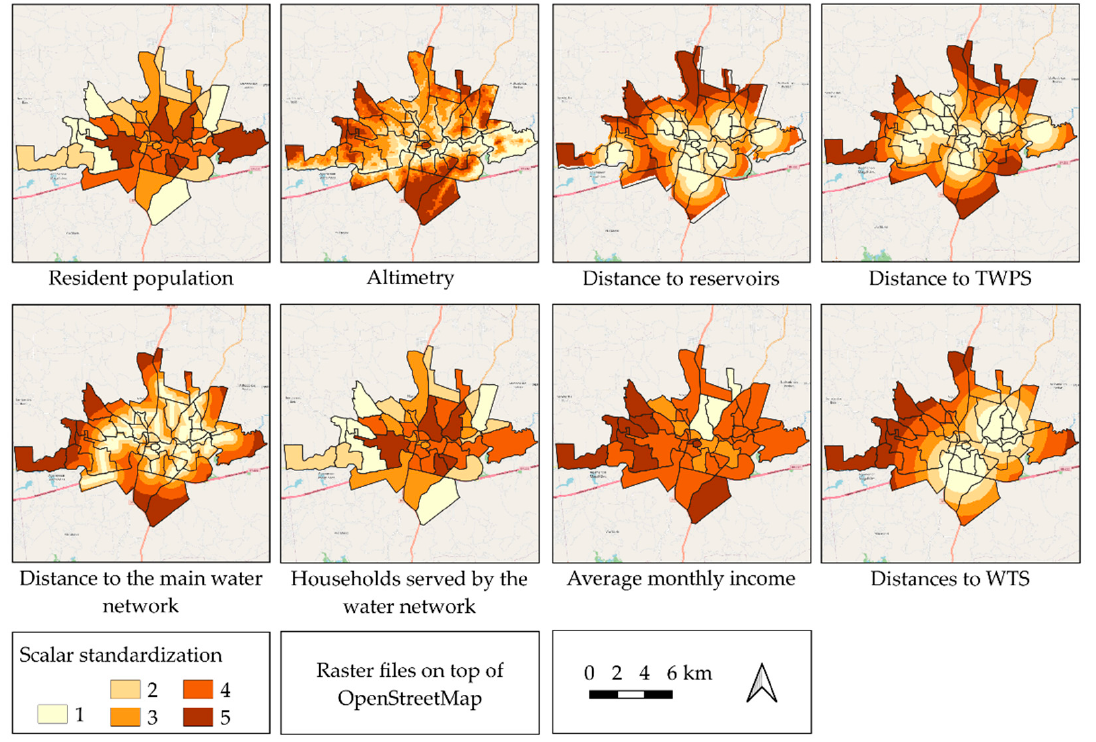
Figure 4. Standardization of criteria to assess the risk of water shortages, using a scale of 1 to 5. The AHP is based on a mathematical structure of n x n matrices; the rows and columns correspond to the n criteria considered for the problem. The value aij represents the relative importance of the criterion in row i against the criterion in column j. The consistency ratio (CR) needs to be evaluated, and, according to [51], it must have a value lower than 0.1 so the values are consistent and the weights can be used. Thus, for [52], the comparison matrices will be constructed by assigning judgments comparing, pair by pair, each element and forming the weights. Table 3, from [53], shows the scale for comparing the criteria according to the degree of importance, pair by